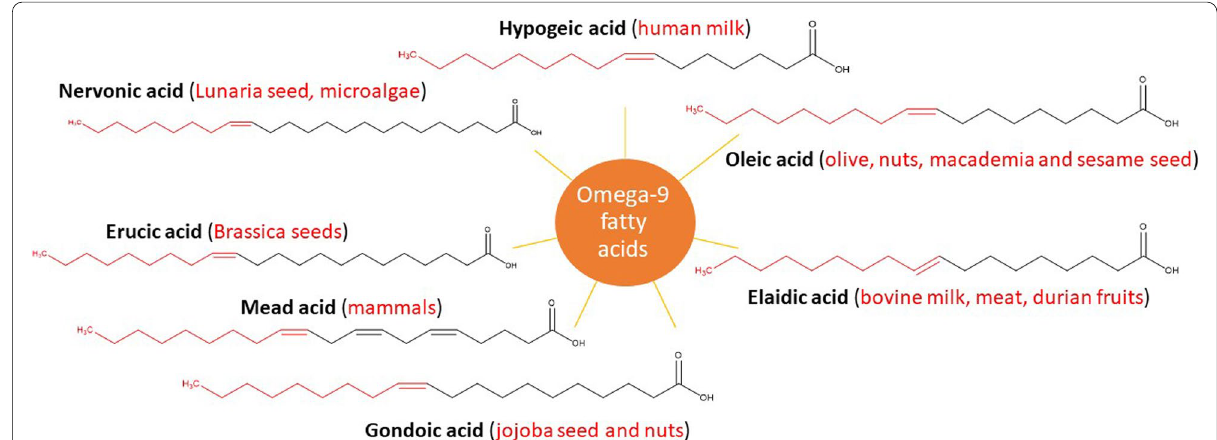
Fig. 1 Common omega-9 fatty acids and their natural sources in plant and